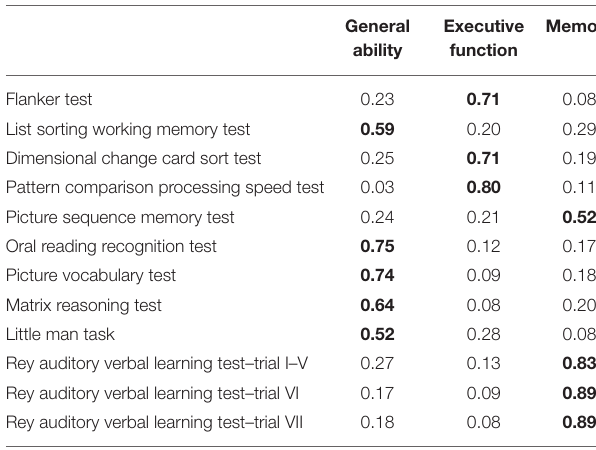
TABLE 3 | Principal component loadings with varimax-rotation for three-component model ( n = 9,116) †